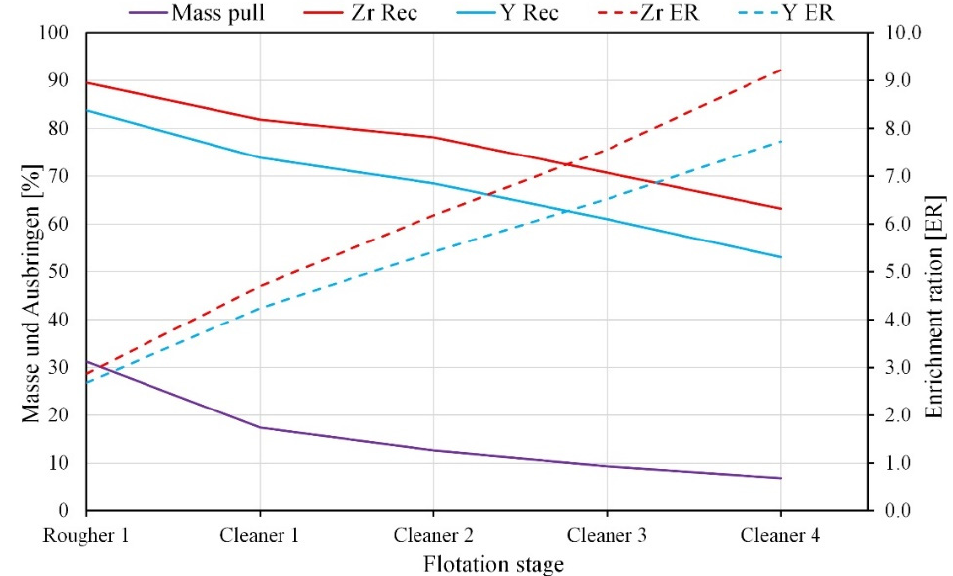
Figure 9. Effect of cleaning stage number on flotation results.